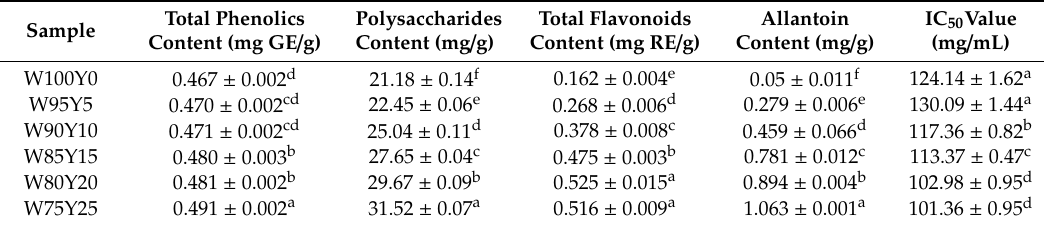
Table 4. Total phenolics content (TPC), polysaccharides, total flavonoids content, allantoin content, and IC50 values of bread with different levels of yam flour.